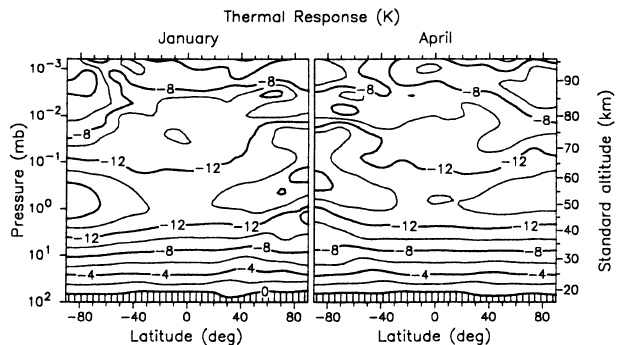
Fig. 8. Temperature di(cid:128)erence (cid:133) 2 (cid:2) CO 2 (cid:255) Control) as a function of pressure for quasi-stationary conditions below 95 km (positive area shaded, contour interval 2 K)